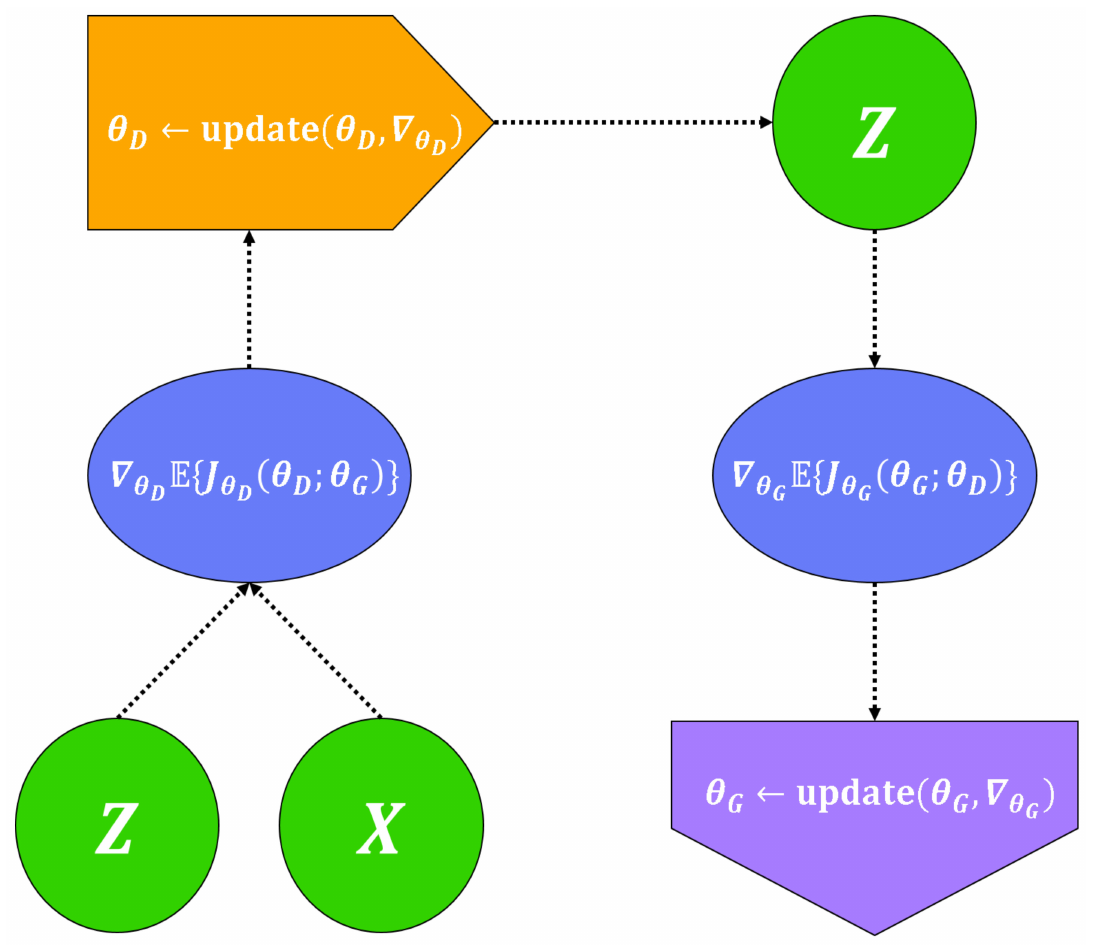
Figure 18. Process of navigating parameters for generators and